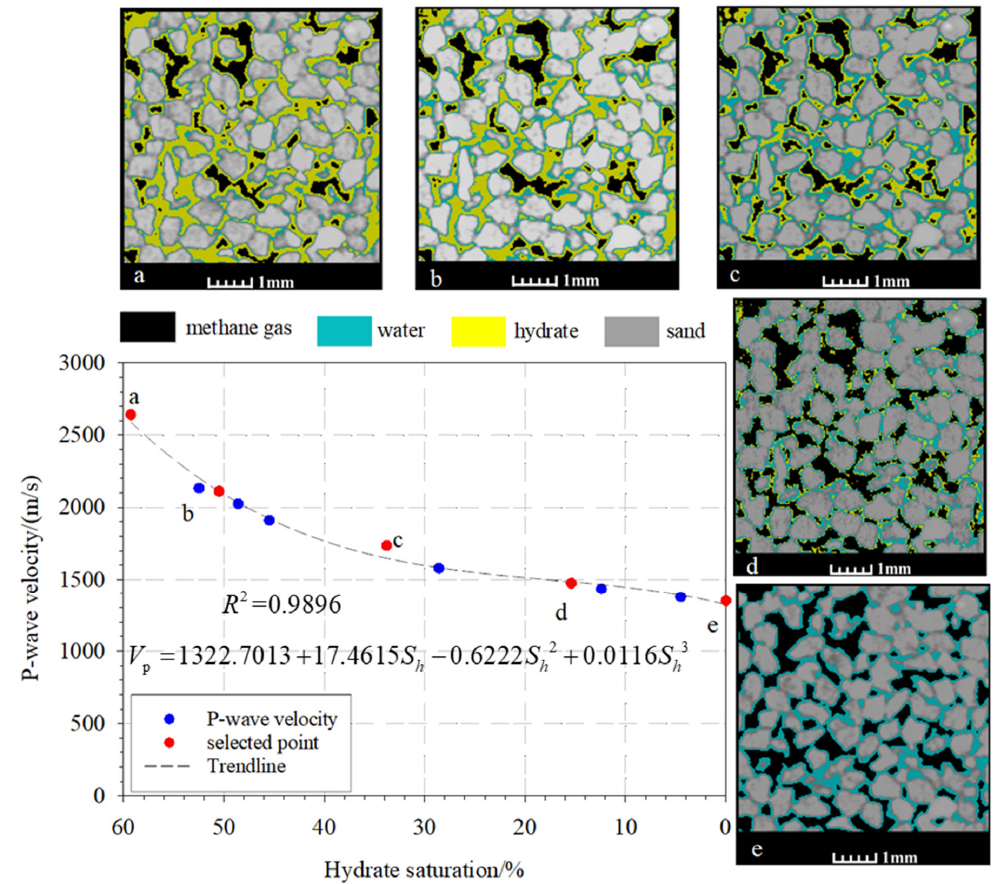
Figure 7. Changes in the microscopic spatial distribution and acoustic characteristics during hydrate dissociation. a–e represent different dissociation stages, corresponding to the points in Figures 2–6.